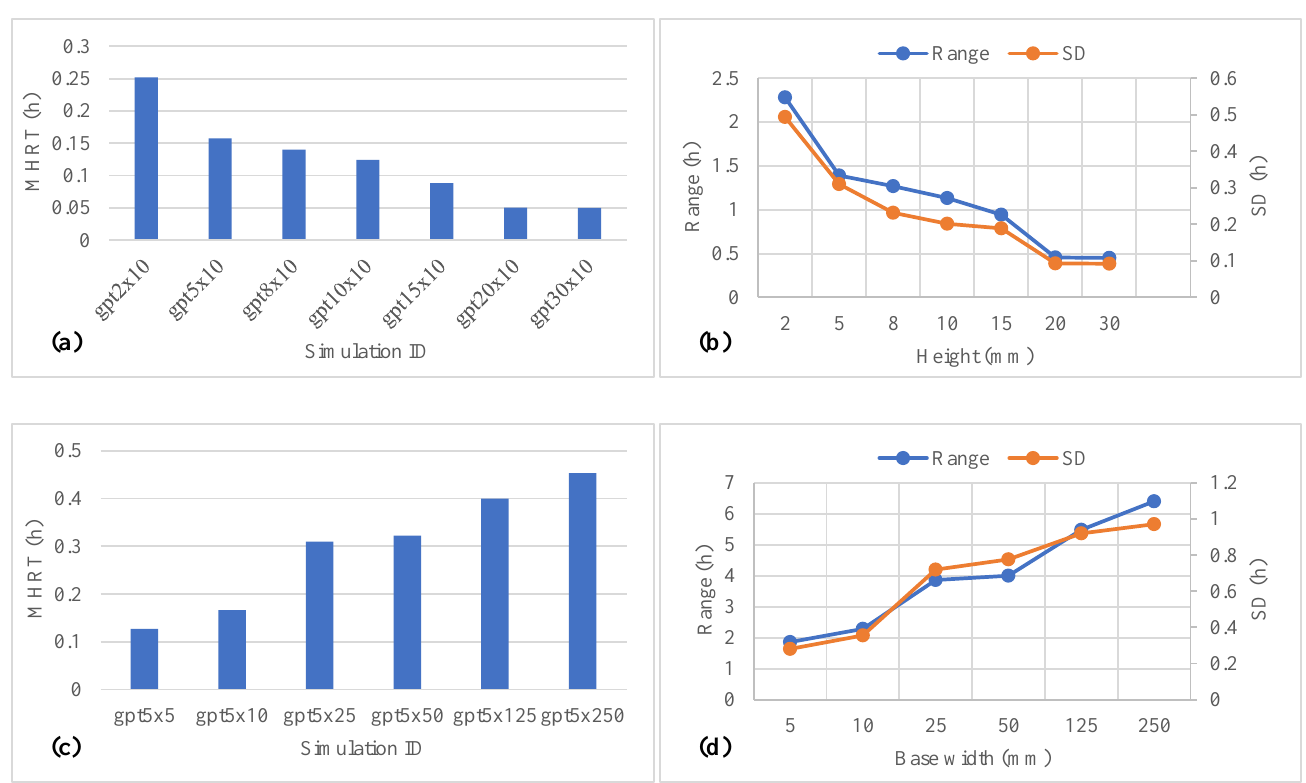
Figure 16. Impact of the size of gravel particle on mean, range, and SD of HRT. Due to an increase in the height of gravel pieces in the figure ( a , b ), mean, range and SD of HRT decreases. On the other hand, with the increase in the base width of gravel pieces in the figure ( c , d ), these values increase. Distribution of HRT for the model setups zgst5 × 10-5, zgst5 × 10-25, are shown in Figure 17a,b, respectively, where the outcomes of the variation in the distribution of gravel and sand portion are illustrated. A decreasing trend in HRT is observed with the increase in the number of gravel/sand zones.